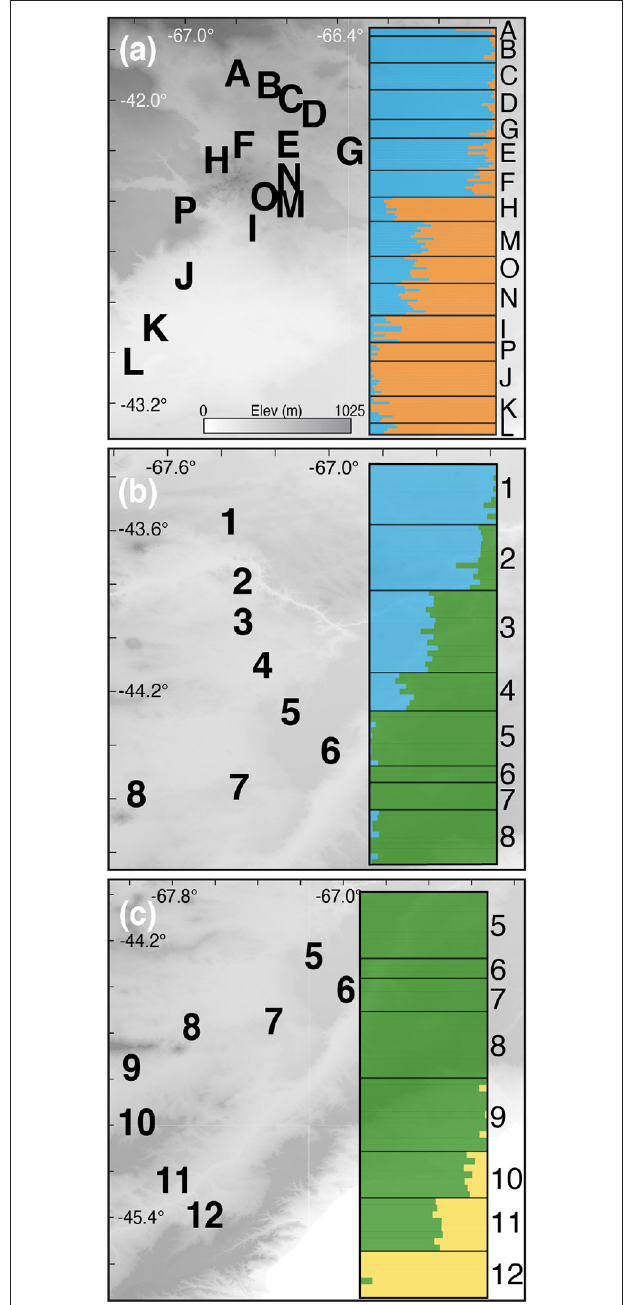
FIGURE 4 | STRUCTURE results and hybrid zone locations for the Northern (A) , Central (B) , and Southern (C) hybrid zones. Latitude and longitude are shown, and the elevational gradient is the same in all maps. Note that populations 5–8 are used in both Central (B) and Southern (C)